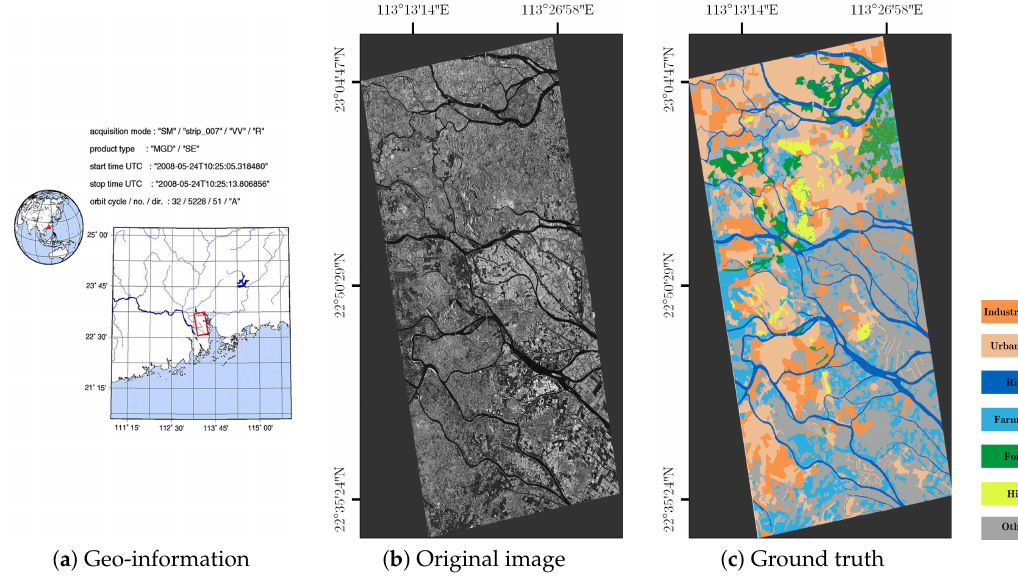
Figure 5. ( a – c ) Experimental SAR image acquired by TerraSAR-X in Guangdong,